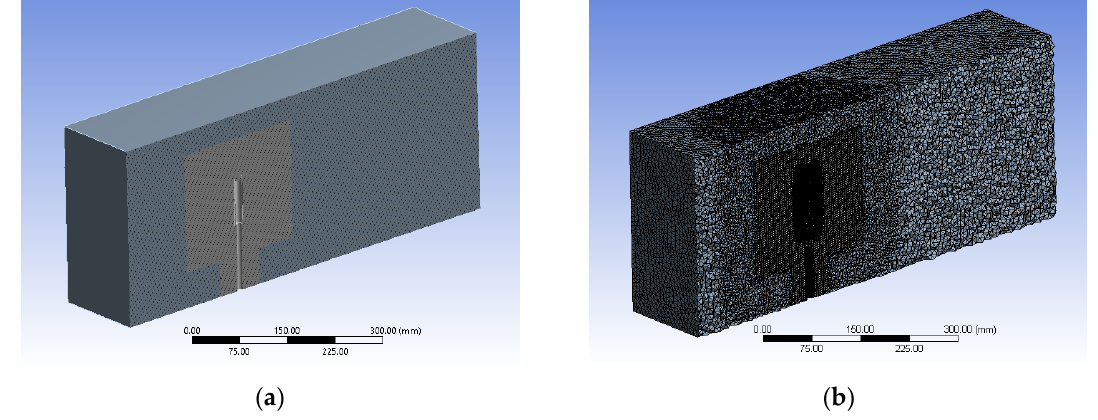
Figure 12. Mesh of the IceWind turbine domain (section): ( a ) elevation and ( b ) side view.